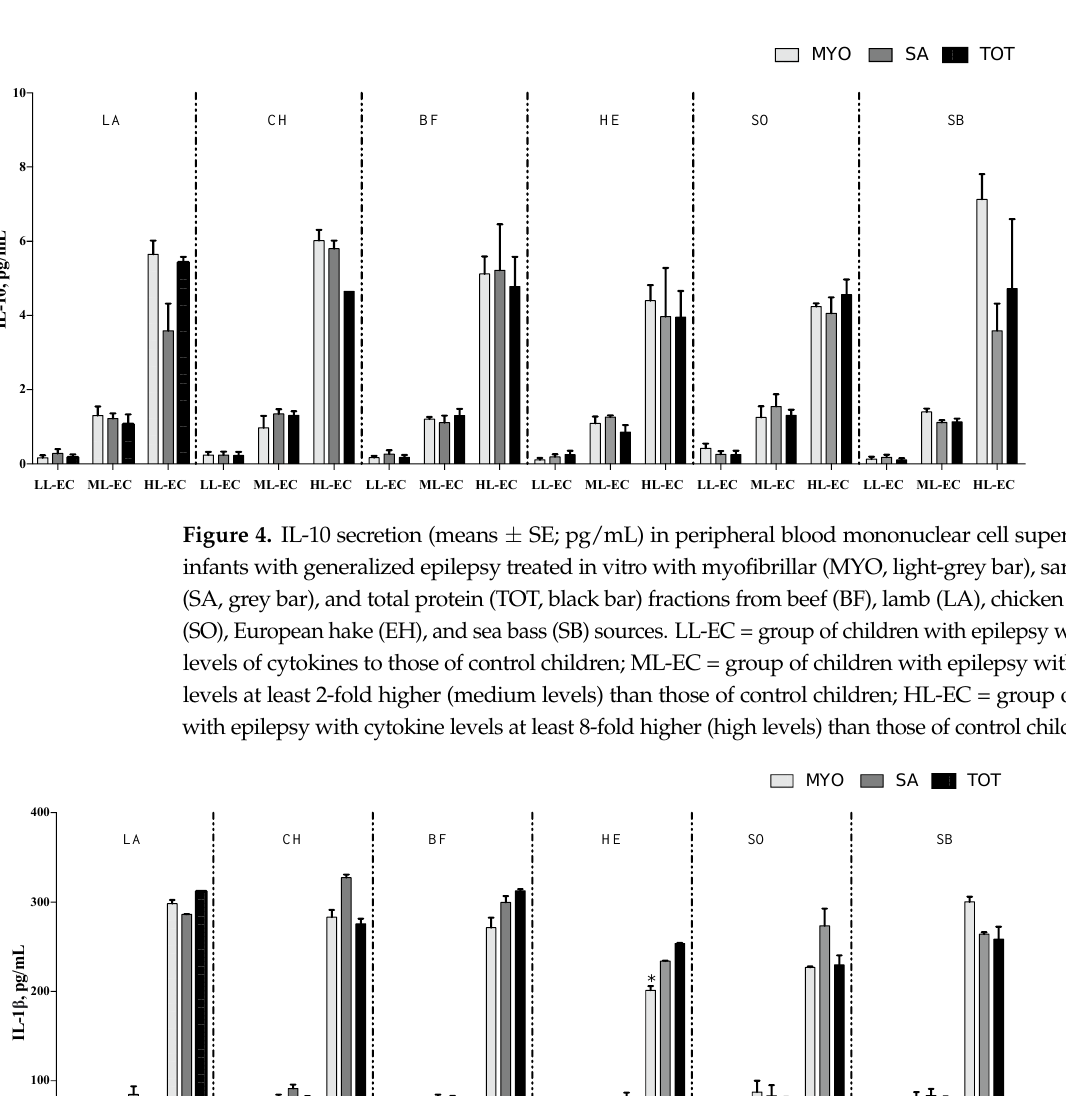
Figure 5. IL- 1β secretion (means ± SE; pg/mL) in peripheral blood mononuclear cell supernatants of infants with generalized epilepsy treated in vitro with myofibrillar (MYO, light-grey bar), sarcoplasmic (SA, grey bar), and total protein (TOT, black bar) fractions from beef (BF), lamb (LA), chicken (CH), sole (SO), European hake (EH), and sea bass (SB) sources. LL-EC = group of children with epilepsy with similar levels of cytokines to those of control children; ML-EC = group of children with epilepsy with cytokine levels at least 2-fold higher (medium levels) than those of control children; HL-EC = group of children with epilepsy with cytokine levels at least 8-fold higher (high levels) than those of control children. * p <